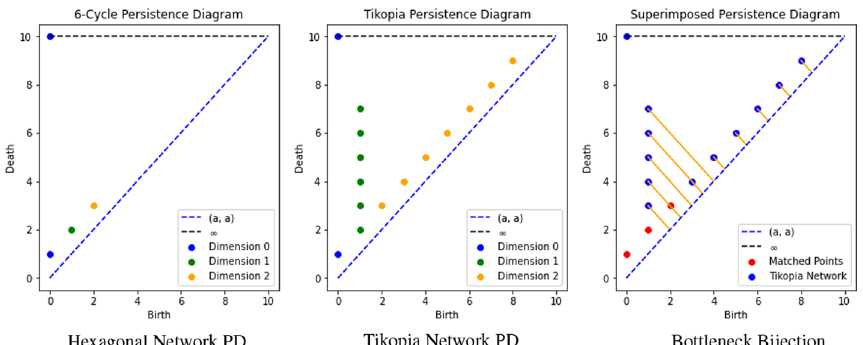
Fig. 6 Left: The persistence diagram of the hexagonal network in Fig. 4b is shown. Center: The persistence diagram of the Tikopia genealogical network in Fig. 1 (left) is shown. Right: A bottleneck bijection between the persistence intervals of the hexagonal and Tikopia family network is shown. Orange lines show which points are matched to points of the form ( a , a ) where a ∈